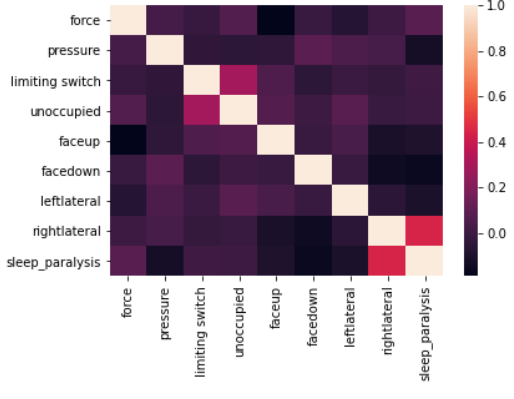
Figure 11. Features Correlation Matrix